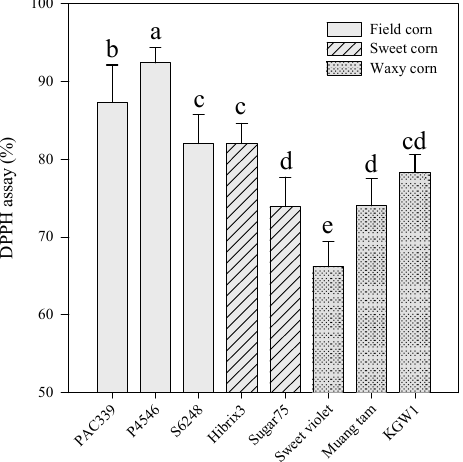
Figure 6. Mean DPPH radical scavenging capacity in the tassels of eight corn varieties. The antioxidant capacity determined by the TEAC method ranged from 54.1 to 61.2 µ mol TE/g DW (Figure 5b). P4546 had the highest TEAC values at the 1st day of pollen shed and 50% and 75% of pollen shed stages (79.1, 79.3, and 76.2 µ mol TE/g DW sample, respectively), KGW1 also had the highest TEAC values at the 1st day of pollen shed and 50% of pollen shed stages (81.3 and 74.9 µ mol TE/g DW sample), and PAC339 had the highest values at 50% of pollen shed (77.2 µ mol TE/g DW sample) (Table 6). However, the antioxidant levels obtained from this research were lower than those obtained in purple corn kernel [35] and fresh corn pollen by TEAC assay in previous studies [9]. The results indicated that the greatest antioxidant activity in the tassels exists in pollen. According to Aliˇci´c, et al. [40], the major components of pollen are carbohydrates, crude fibers, proteins, and lipids, and the minor components include minerals, trace elements, vitamins, carotenoids, phenolic compounds, flavonoids, sterols, terpenes, and amino acids. Although a number of these components have antioxidant activity, phenolics contribute the most to antioxidant activity in pollen [9]. Thus, the late tassel developmental stage with the lowest level of pollen grains had the lowest pollen fresh weigth and pollen dry weight, resulting in a reduction in the antioxidant